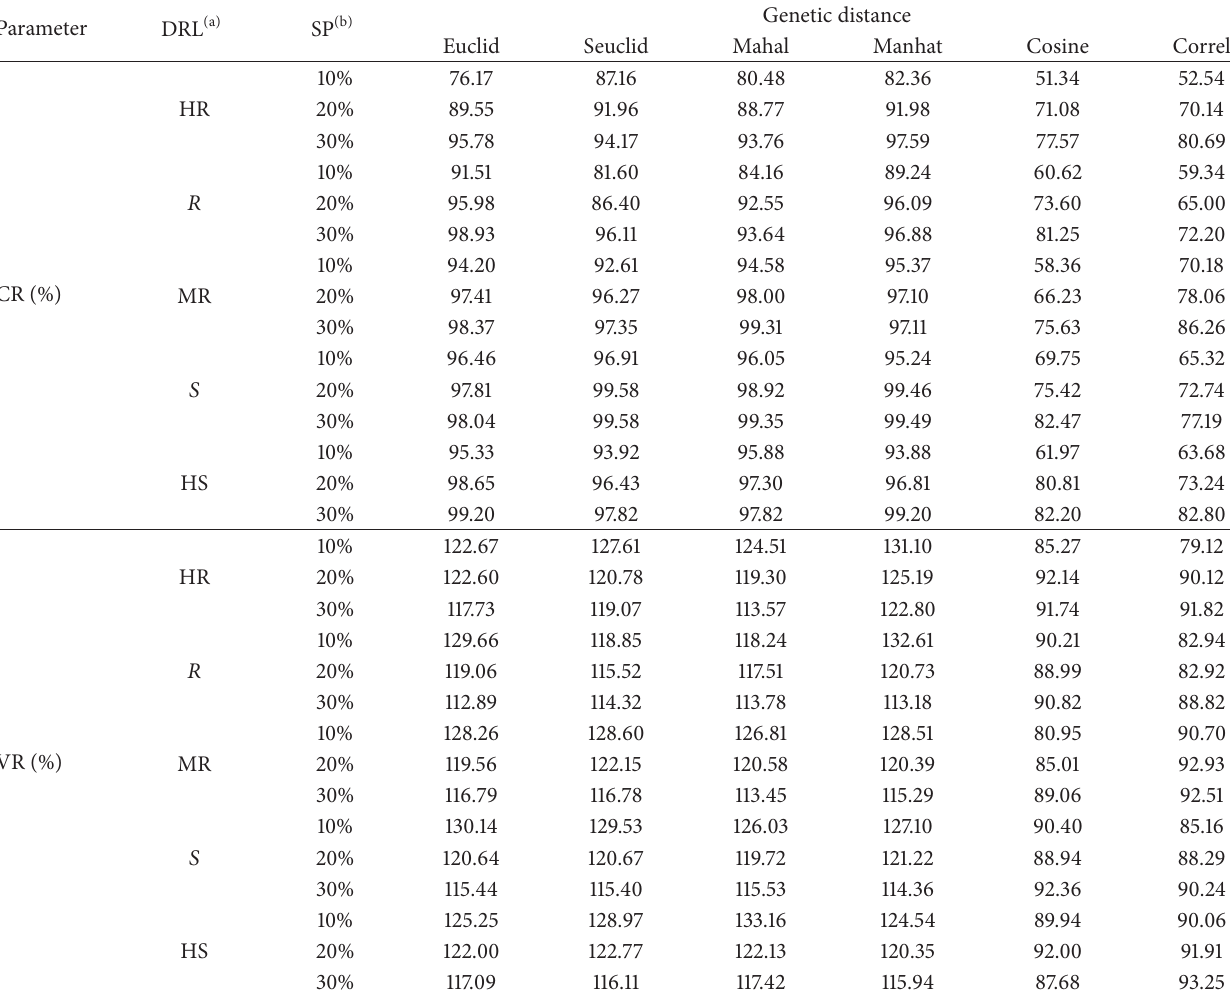
Table 1: The values of CR and VR of different subcore collection constructed by six genetic distances at the sampling percentage of 10%, 20%, and